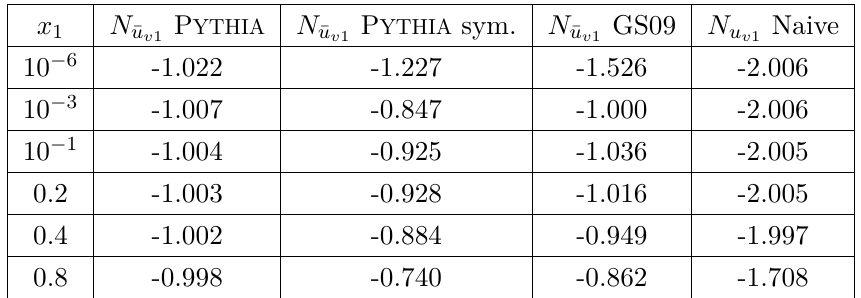
Table 5 . Numerical integration with respect to x 2 over R ∗